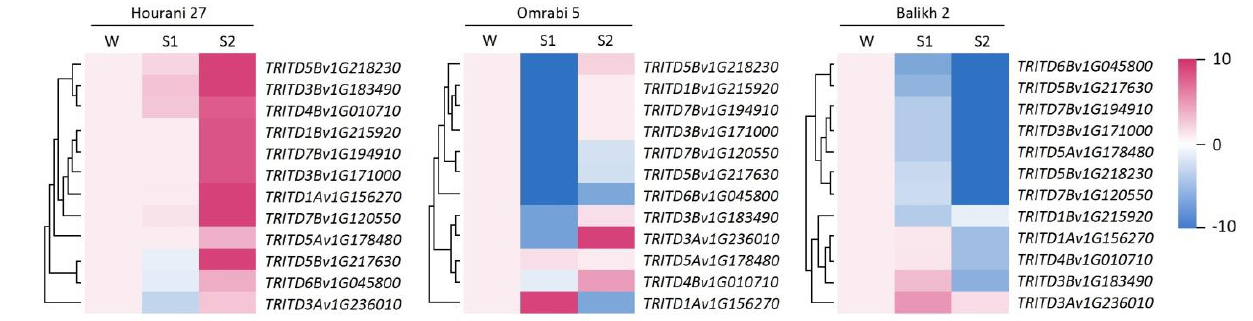
Figure 5. Heat maps of relative expression of drought-responsive memory genes in three durum wheat cultivars (Hourani 27, Omrabi 5 and Balikh 2) during S1 and S2 stress stages as compared to the control W. Presented folds range from − 10 to 10.